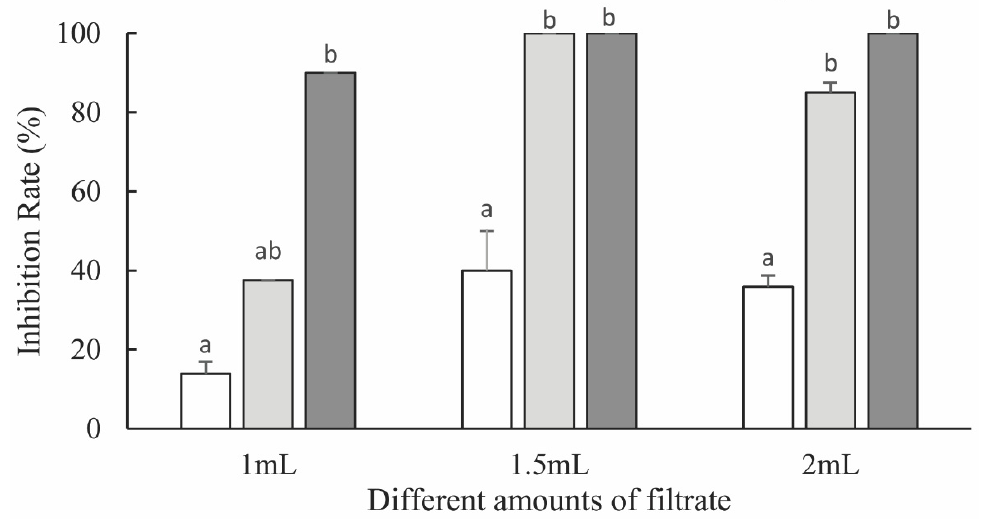
Figure 4. Inhibitory effect of Brachybacterium phenoliresistens against three plant pathogens with different amounts of filtrate. For each amount of filtrate, bars with the same letter are not significantly different ( p > 0.05, Mann–Whitney U test).